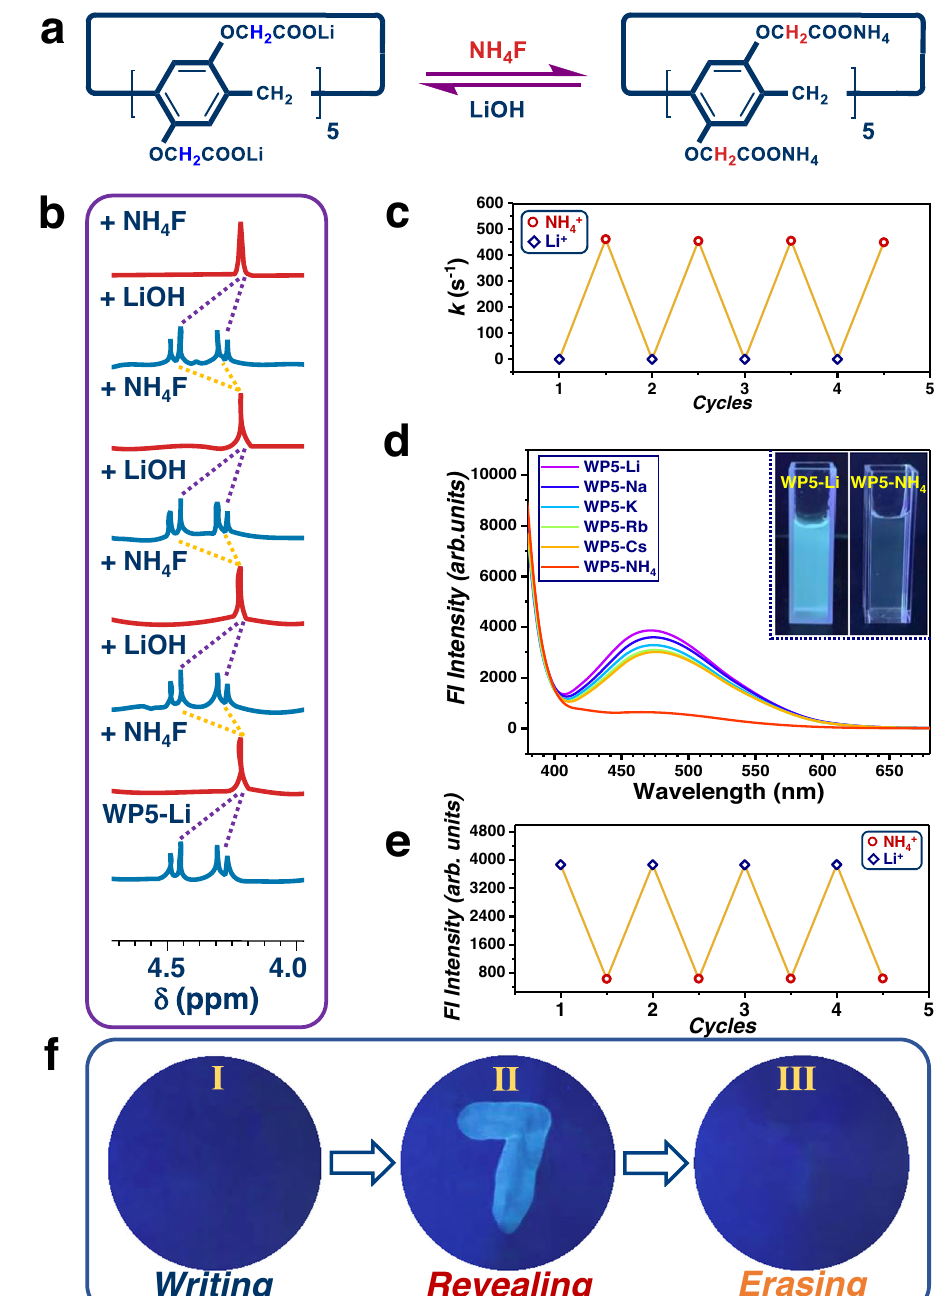
Fig. 6 | Rotational speed control and fl uorescence switch of WP5-M. a Cation responseof WP5 (5.0mM)at471nmuponmultiplecyclesofcationswitchbetween Li + and NH 4 + in D 2 O ( λ ex =365nm). f Revealing and erasing information with WP5 switch between Li + and NH 4 + . b Partial NMR of switching control of rotors. c Switchingofratefor WP5 inD 2 Oat298Kwithmultiplecyclesofcationexchange. inks: the image written with WP5-NH 4 under 365nm light (I), and the image could d Fluorescence emission spectrum of WP5-M ( c =5.0mM, λ ex =365nm; insert: be observed upon adding LiOH on the pre-existing images (II), which could be fl uorescenceof WP5-Li and WP5-NH erased by painting NH 4 F 4 under365nmUVirradiation). e Fluorescence